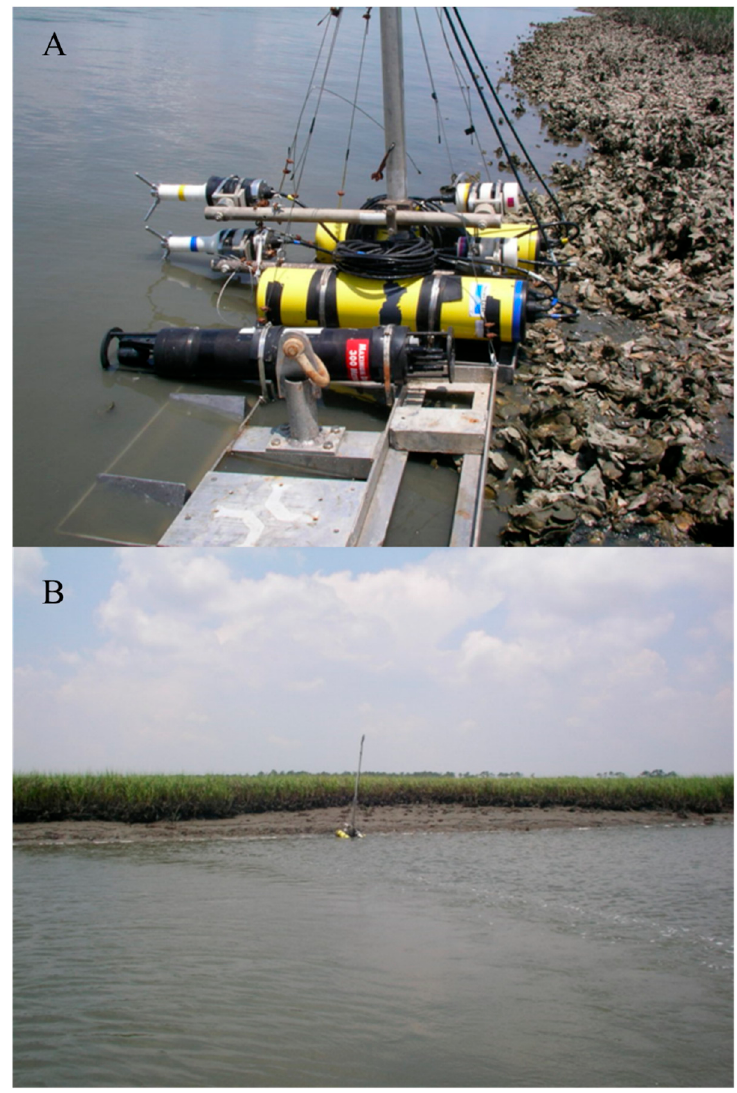
Figure 3. Instrument package deployed at ( A ) Station 1 and ( B ) Station 2. Instruments were deployed near low tide and include a pair of vertically stacked ADVs. The sampling volumes extend towards the center of the channel. The electronics and batteries were housed in the yellow cylinders. Guy-wires were used to steady the vertical mount to reduce vibrations caused by turbulence generated by the mean flow or energetic vessel wake that may introduce noise in the flow measurements. A flag was installed so that the location of the instrument package would remain visible at high tide.